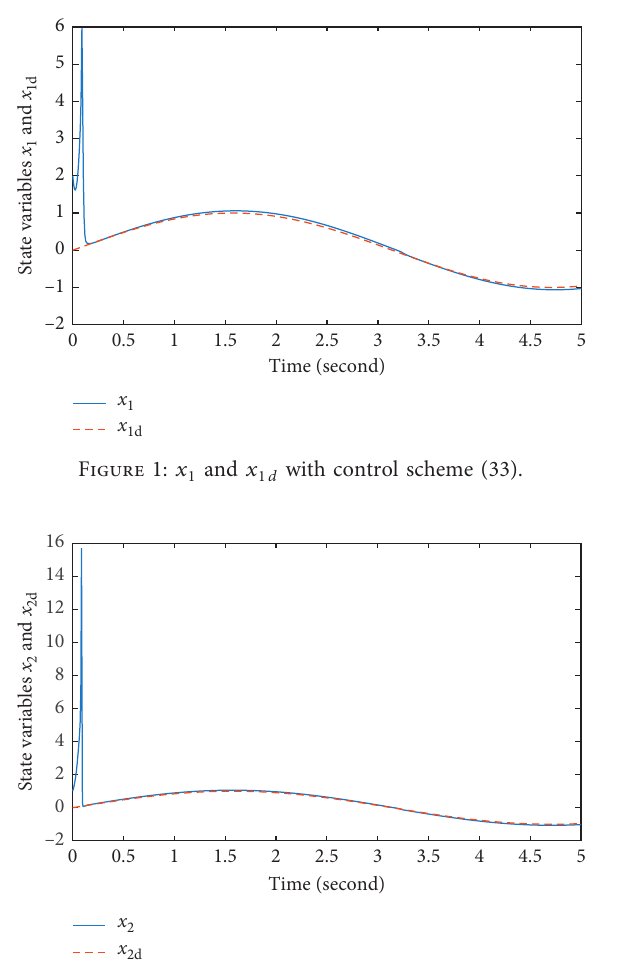
and x with control scheme (33). 2 2 d